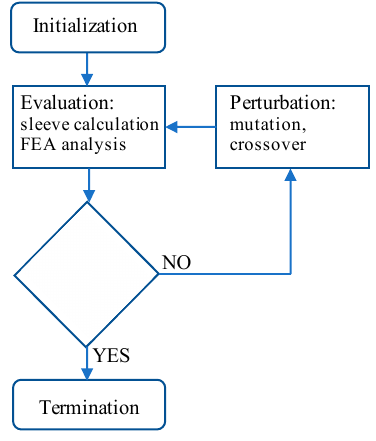
Figure 4. Flow-chart describing the optimization procedure. Table 2. Limits of the search